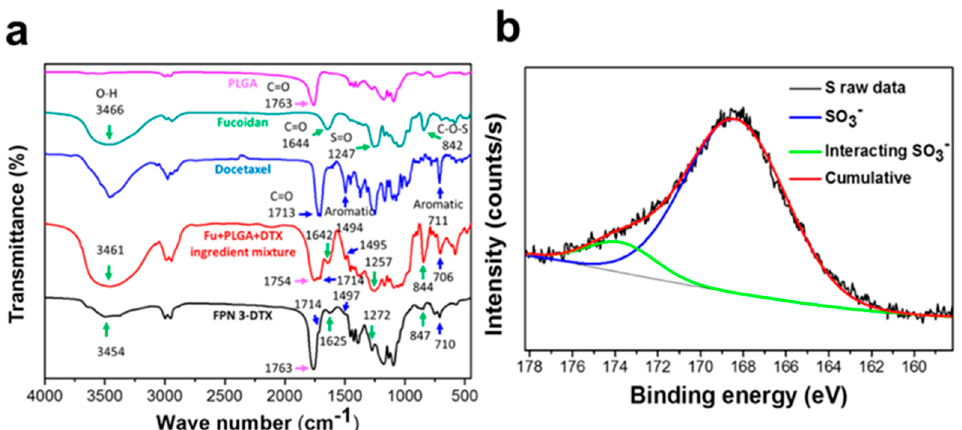
Figure 5. ( a ) Fourier transform infrared (FTIR) spectra of PLGA, fucoidan, docetaxel, powdered mixture of three main ingredients, and FPN 3-DTX. ( b ) Cumulative sulfur 2p (S 2p) X-ray photoelectron spectrum of FPN 3-DTX based on X-ray photoelectron spectroscopy (XPS).